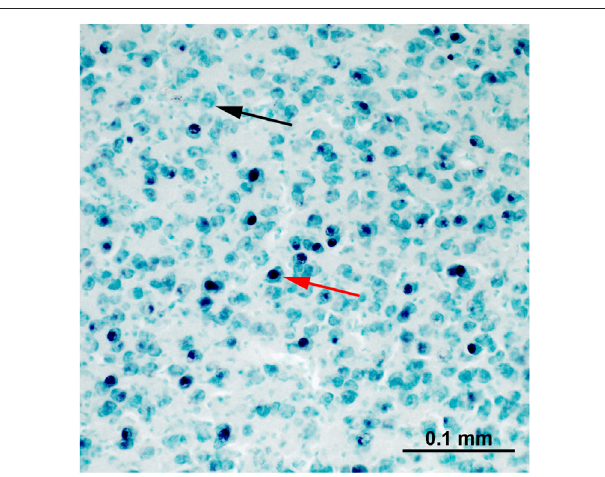
FIGURE 4 | An example of c-Fos staining within the nucleus taeniae of the amygdala. The nuclei of c-Fos immunoreactive cells are stained black (red arrow). The c-Fos-negative cells (black arrow) are green due to the methyl- green counterstaining.